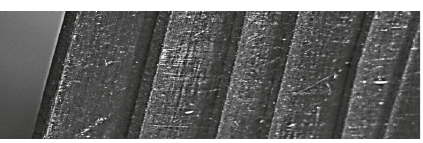
Figure 12: Calibration